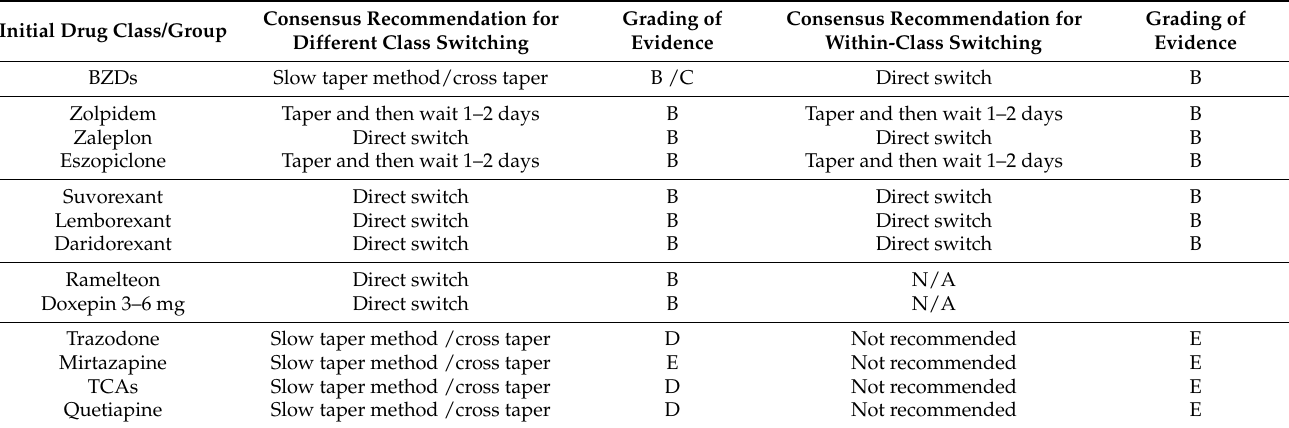
Table 2. Consensus recommendation for switching insomnia medications, both within-class and to a new drug